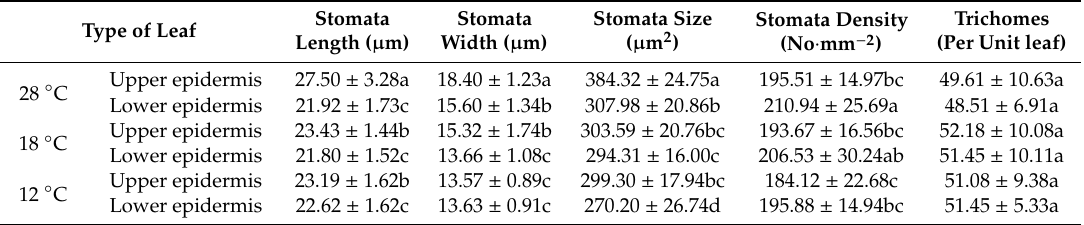
Table 1. E ff ect of chilling stress on stomatal characteristics and trichomes number of rice